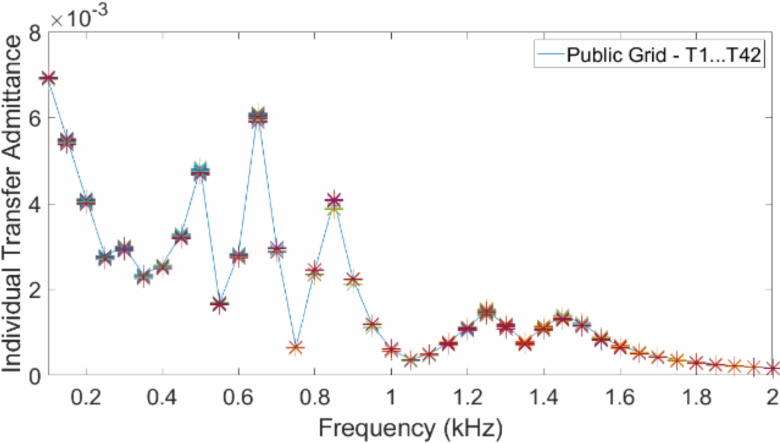
Figure 9. Transfer admittance (A/V) from public grid to turbines: 5-turbine wind power plant.